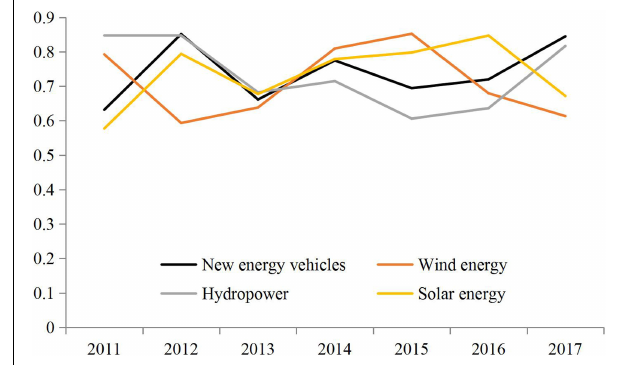
FIGURE 7 | Comprehensive correlation between the efficiency of the four new energy industries and